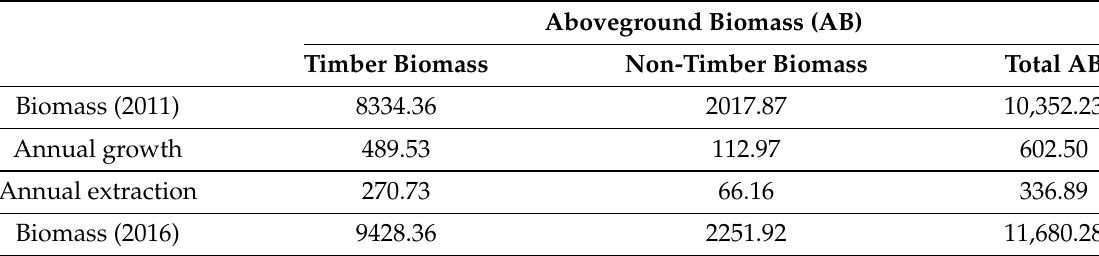
, Mg ha − 1 year − 1 ). Annual i